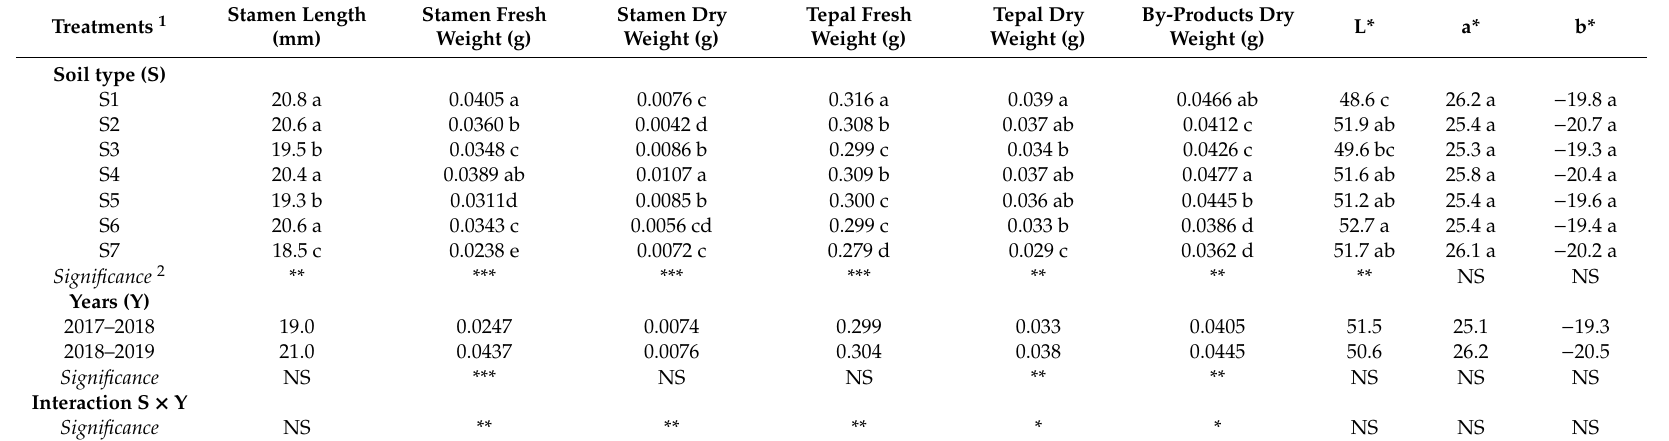
Table 2. E ff ect of the soil type on morphological and colorimetric traits of sa ff ron flower in two years. Treatments